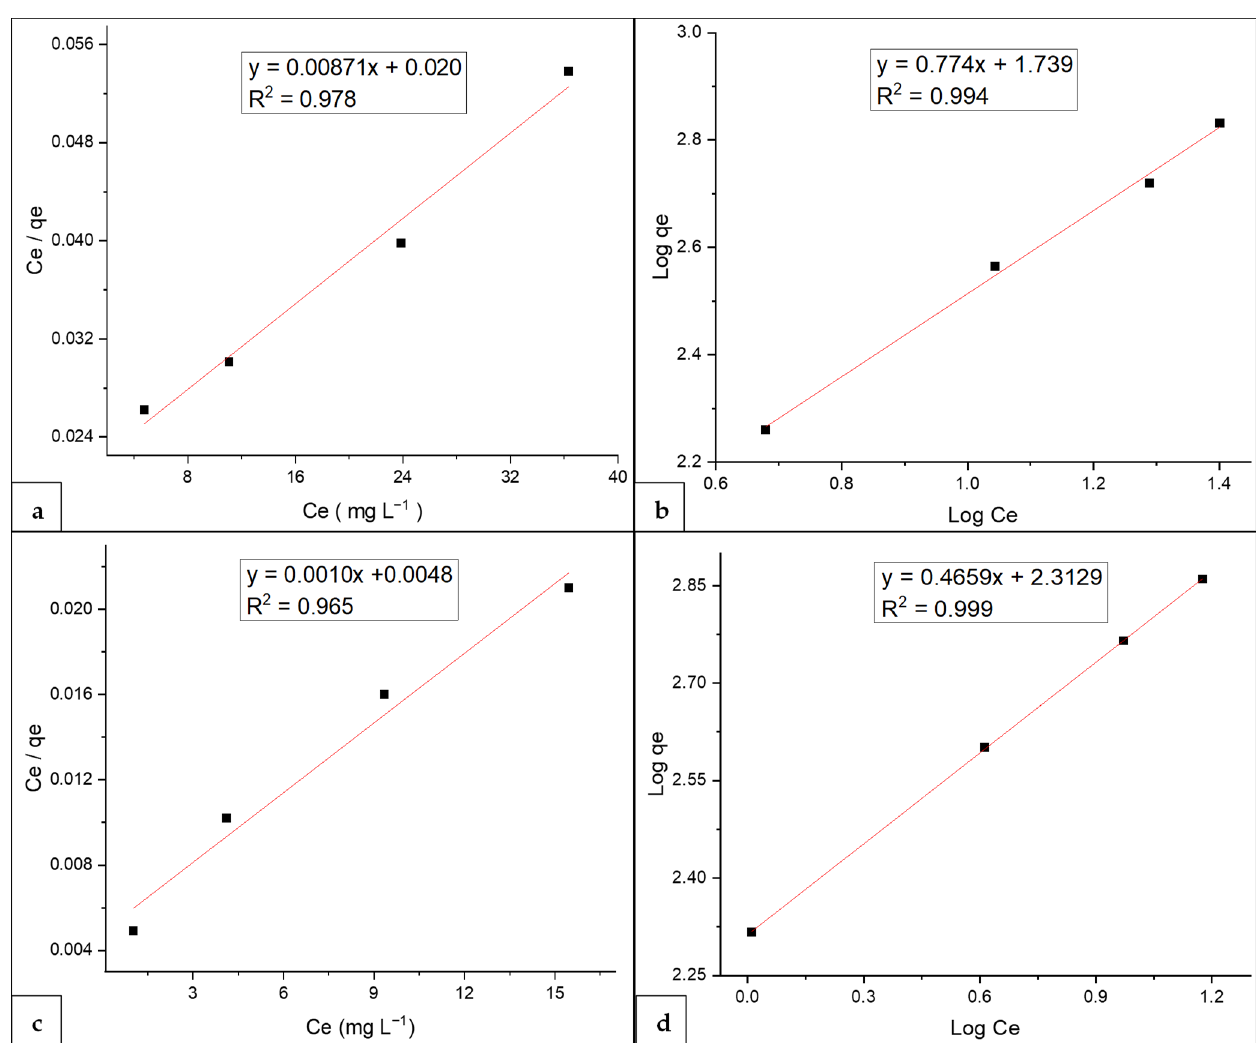
Figure 13. MB adsorption isotherms ( a ) Langmuir and ( b ) Freundlich model using SAP and ( c ) Langmuir and ( d ) Freundlich model using SAP-AC as adsorbent. Table 4. Isotherm parameters of MB adsorption on SAP and SAP-AC as